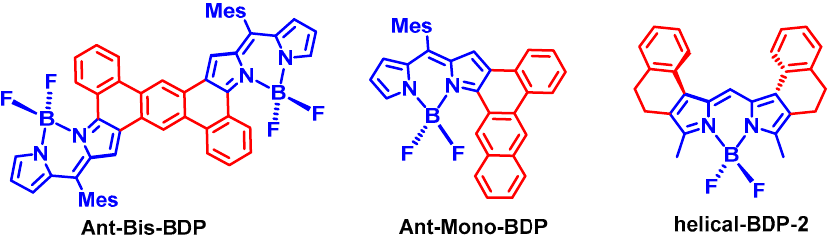
Figure 10. Bodipy derivatives with a twisted π -conjugation system in the molecular structure. ISC was observed for these